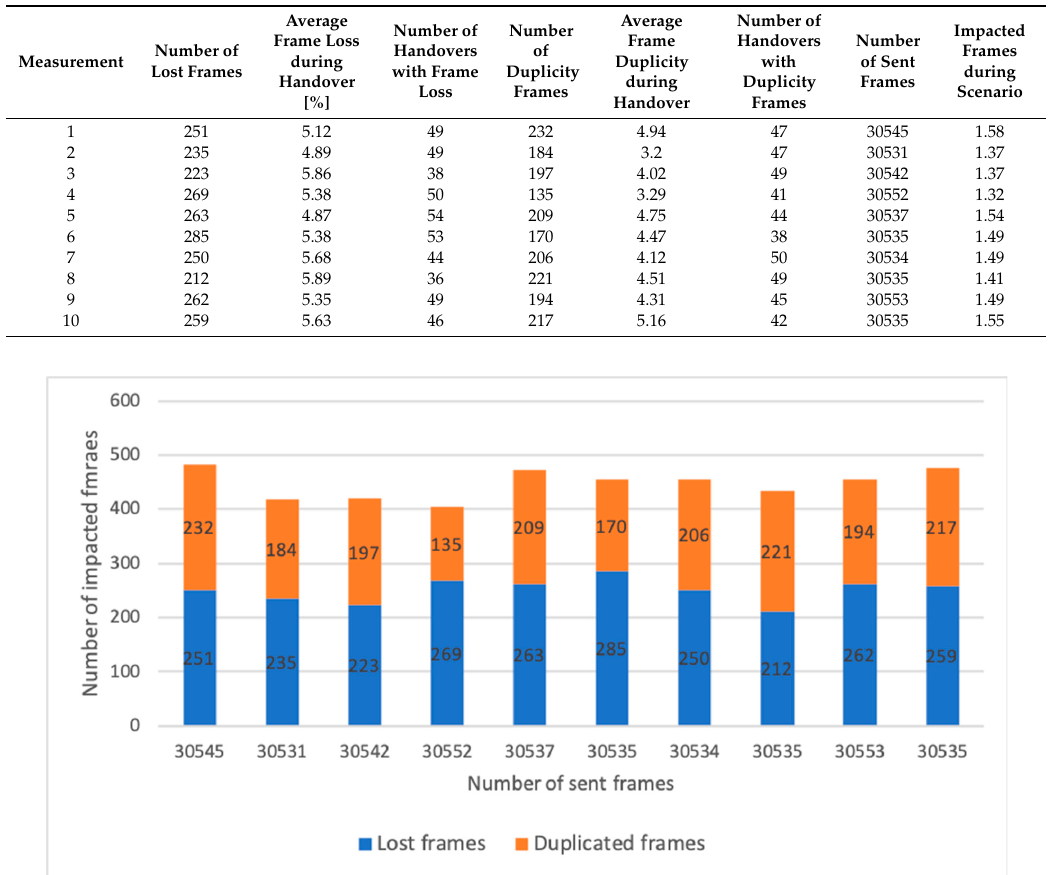
Figure 7. Number of impacted frames during measurements.